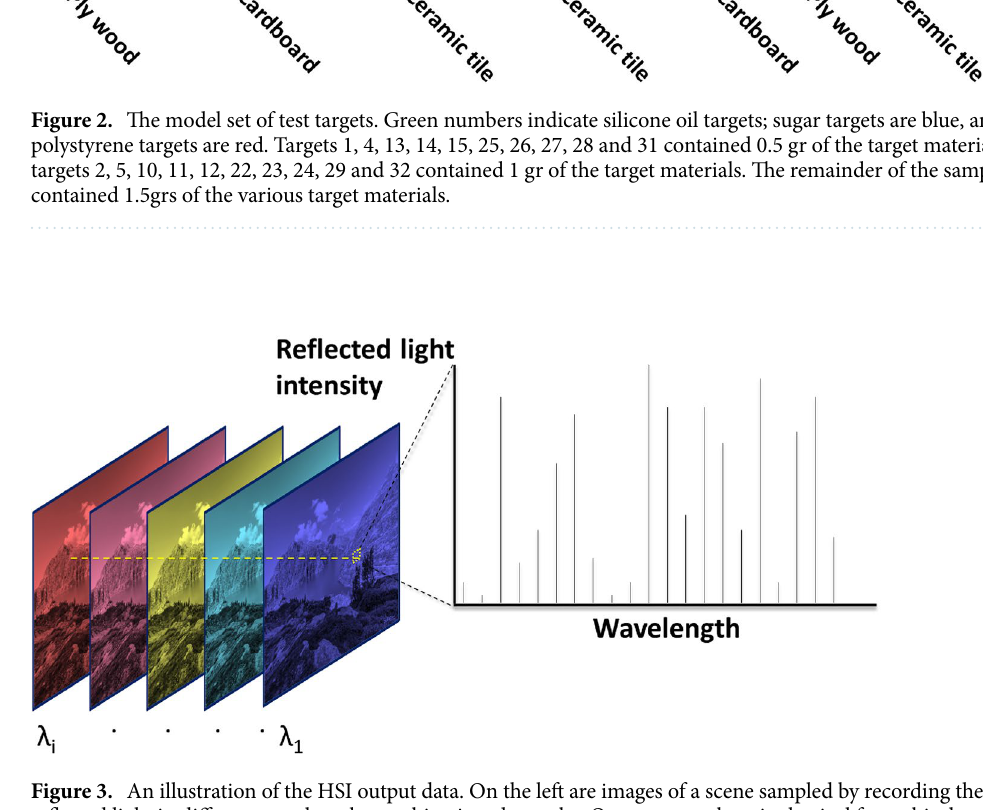
Figure 3. An illustration of the HSI output data. On the left are images of a scene sampled by recording the reflected light in different wavelengths resulting in a data cube. One can sample a single pixel from this data cube and obtain the spectrum of the light reflected from this pixel, as shown on the right-hand